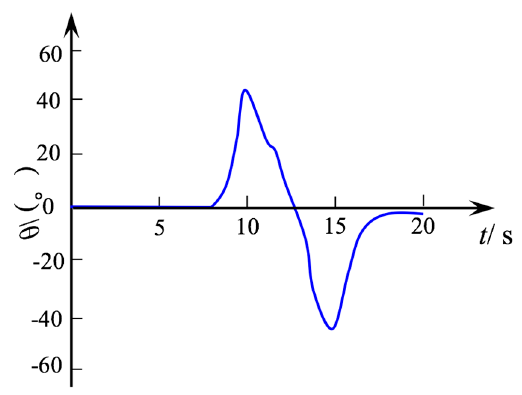
Figure 10. The measured deflection angle with